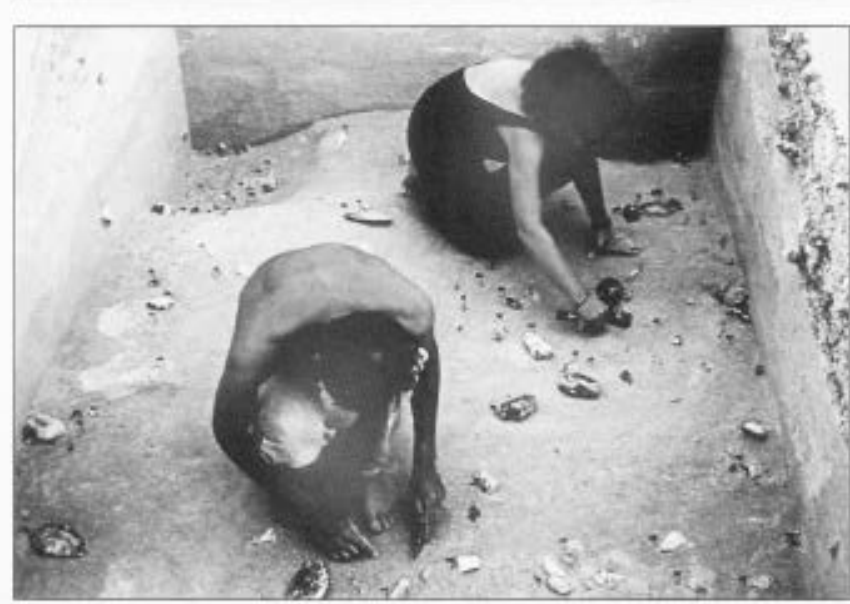
Figure 5 Excavating bifaces at the waterhole site, Ql/B. Over 450 mint-condition bifaces were recovered from the freshwater deposits at this